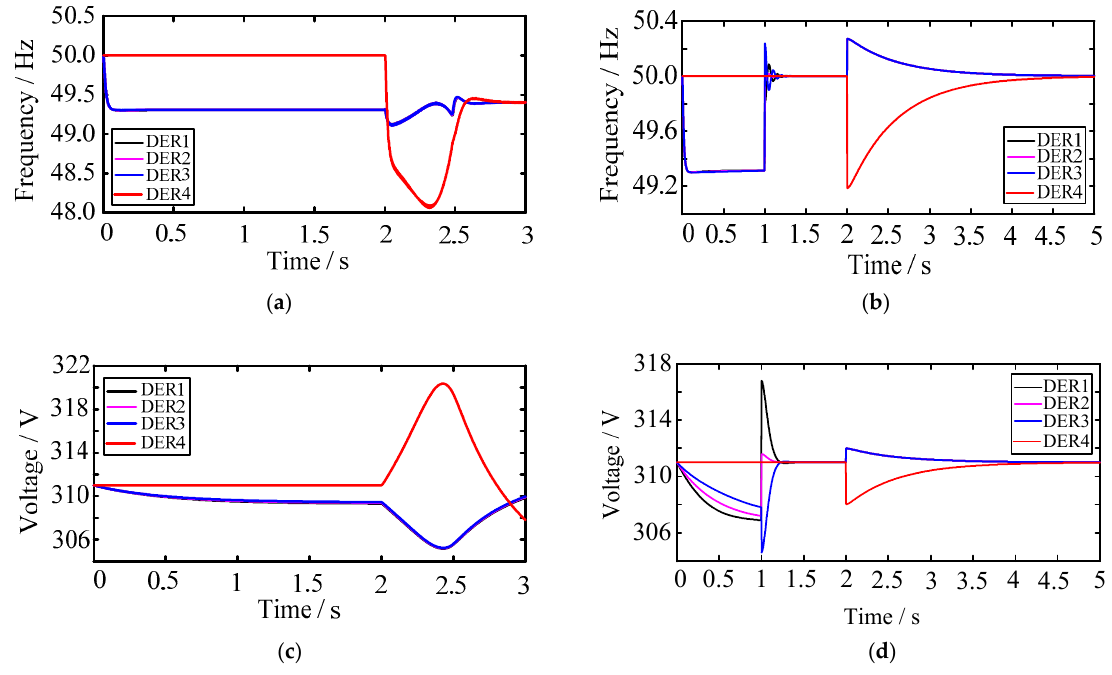
Figure 8. Variations of DERs when DER4 is added at t = 2 s. ( a ) Variations of voltage by using traditional droop control; ( b ) Variations of voltage by using the novel distributed control; ( c ) Variations of frequency by using traditional droop control; ( d ) Variations of frequency by using the novel distributed control.